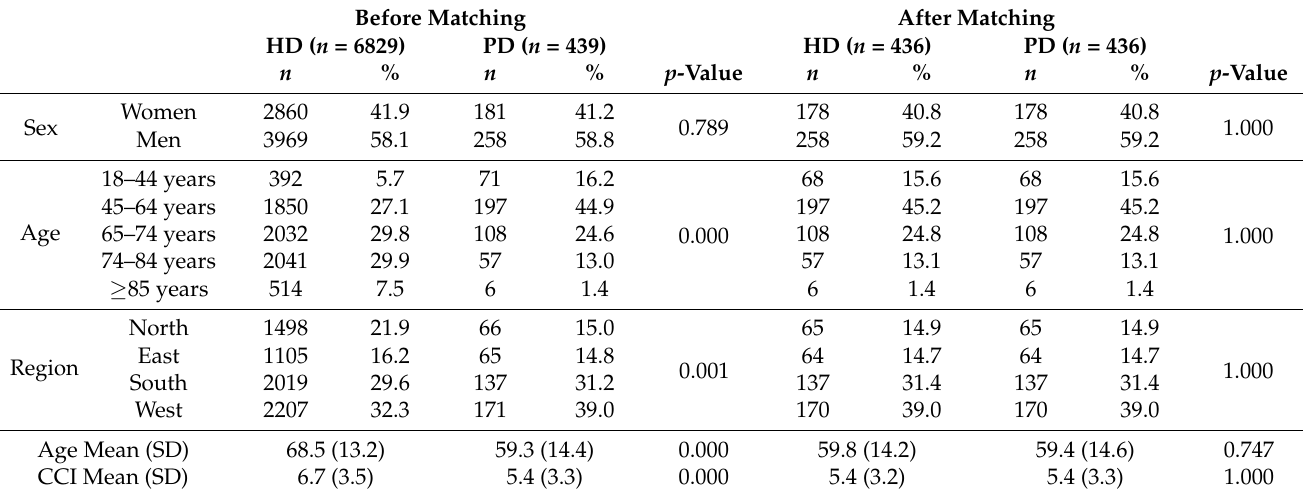
Table 1. Characteristics before and after